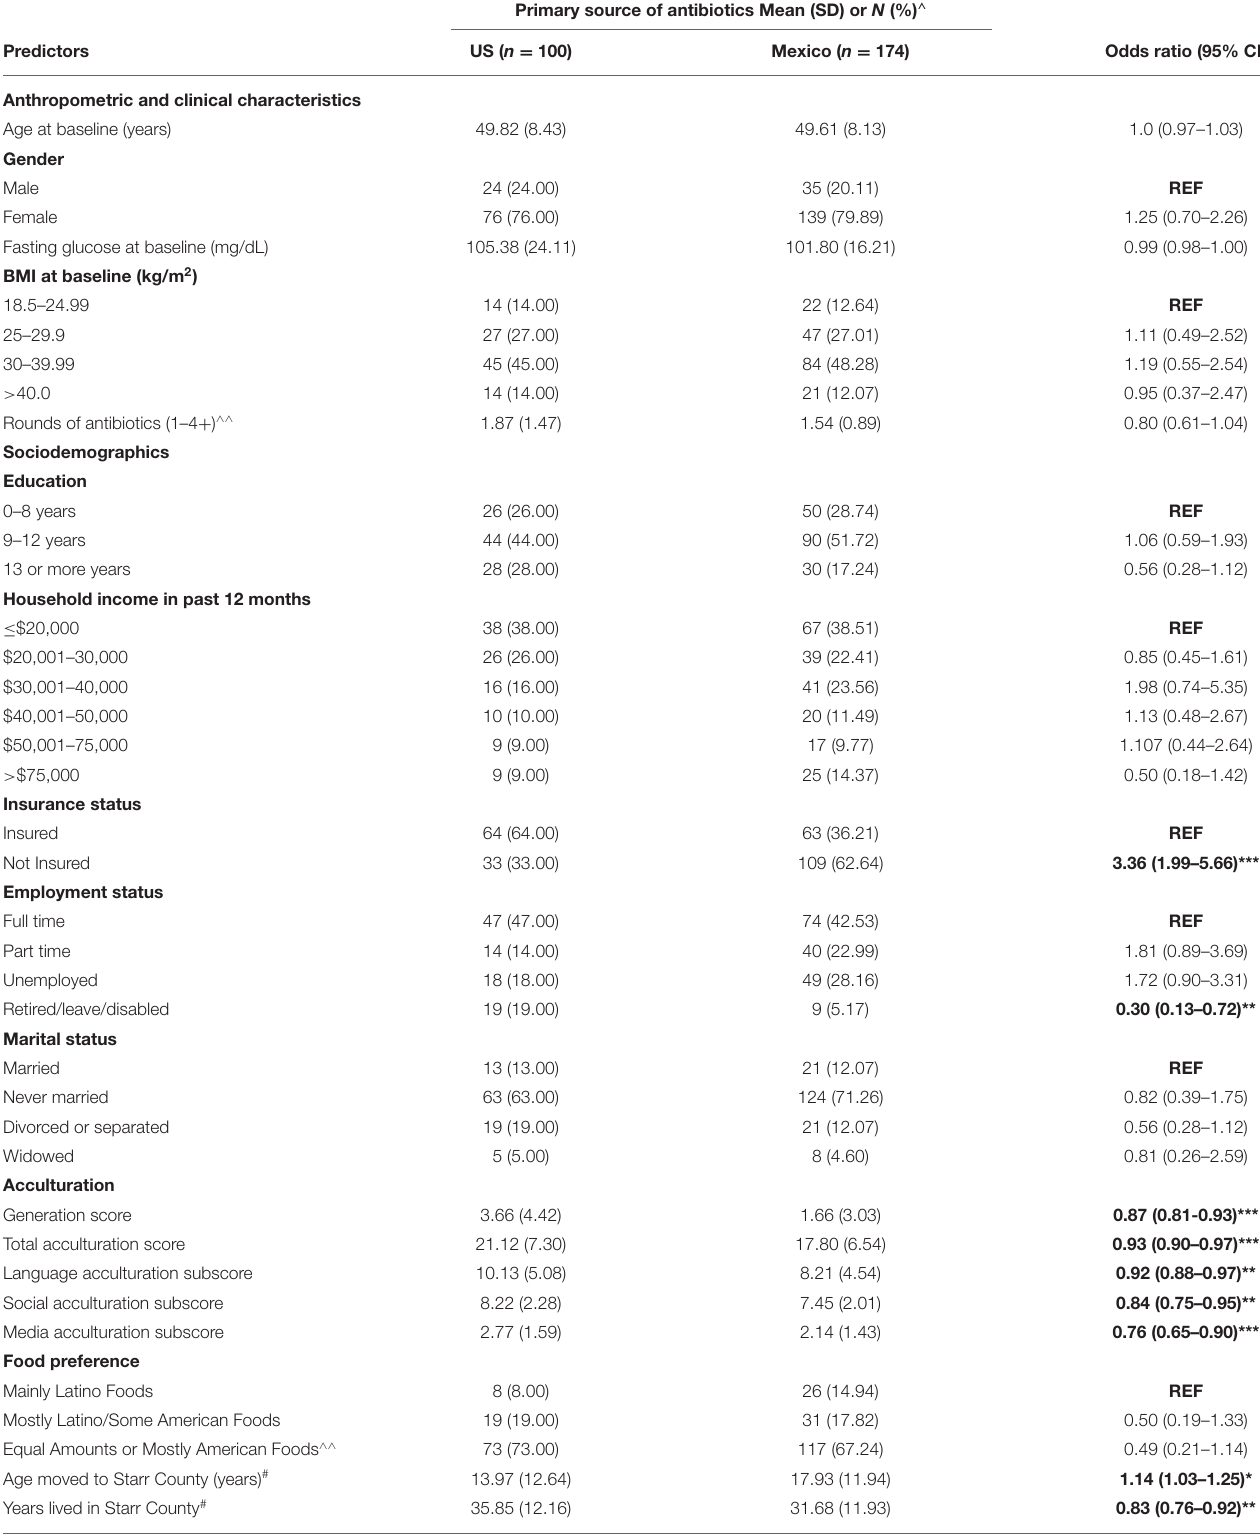
TABLE 3 | Univariable logistic regression: odds of preferentially sourcing antibiotics from